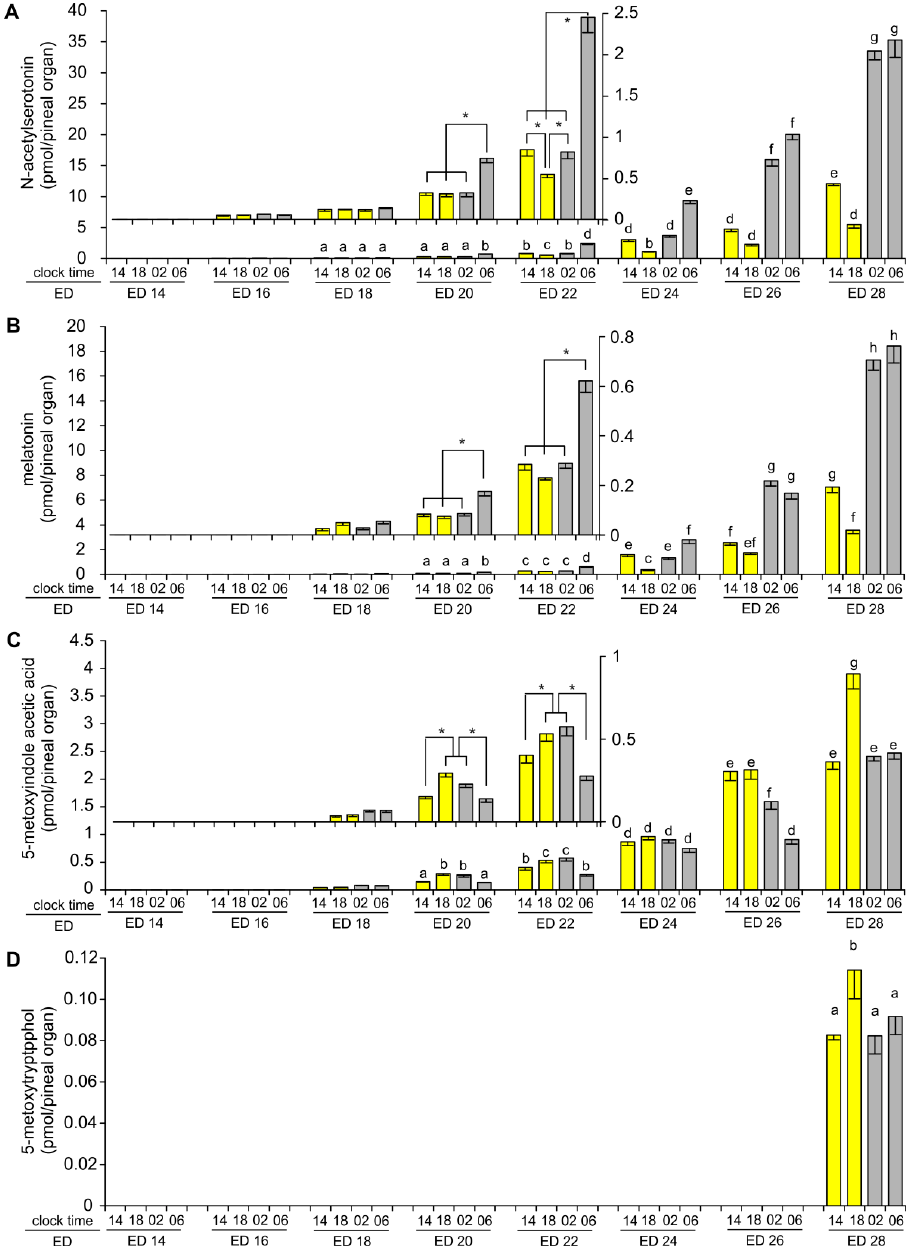
Figure 3. Content (means and SEM, n = 5) of N-acetylserotonin ( A ), melatonin ( B ), 5-methoxyindole acetic acid ( C ) and methoxytryptophol ( D ) in the pineal organ of geese embryos. Values labeled with different letters are significantly different in Duncan’s test performed as a post hoc procedure after two-way ANOVA. Inserts: Enlarged parts of charts showing data from ED 14, ED 16 and ED 18 embryos. Significant differences between sampling time points as showed by one-way ANOVA and Duncan’s test were signed with asterisk (*).